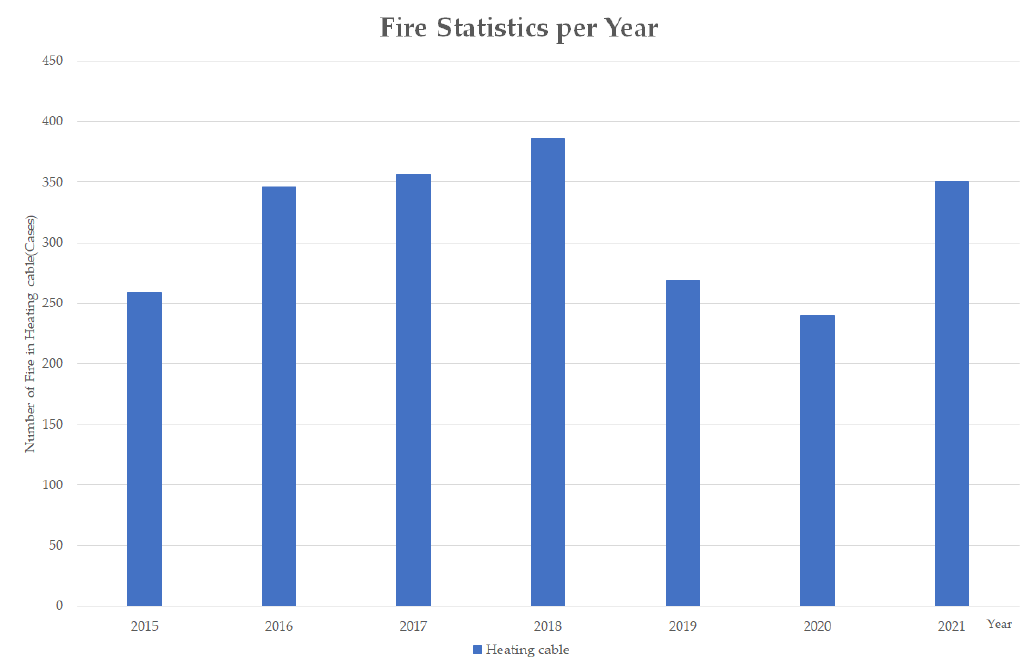
Figure 5. Fire statistics related to heating per year.